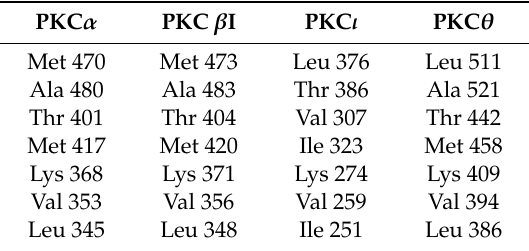
Table 4. Corresponding amino acid residues in di ff erent PKC isoforms.